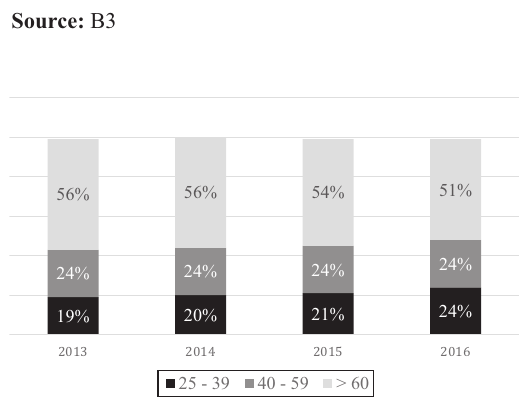
Figure 3. Gender participation